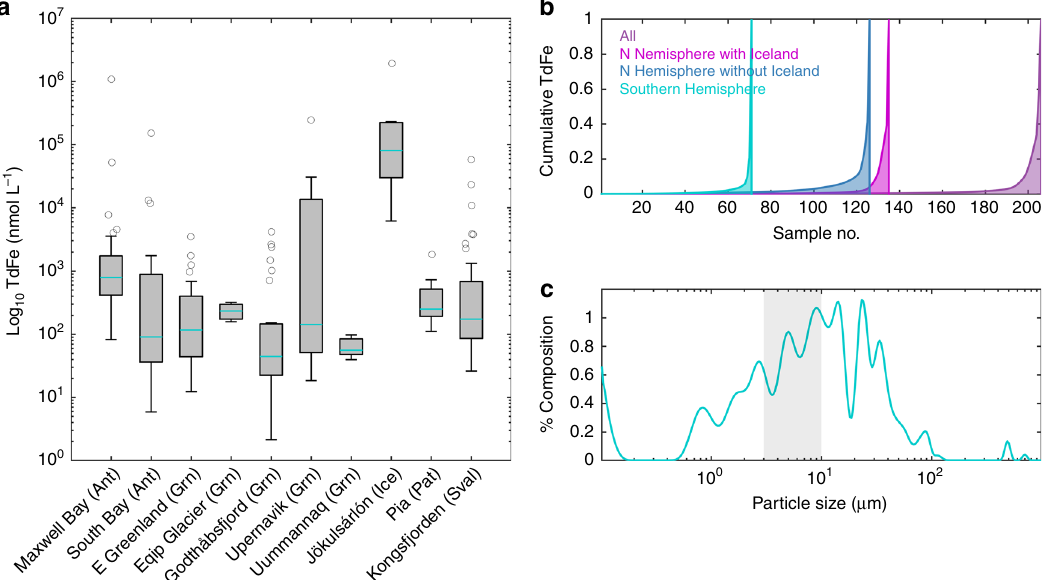
Fig. 1 Iceberg iron and particle content. a Iceberg iron (total dissolvable Fe) content per catchment. Boxes show median, 25 th and 75 th percentiles; whiskers show 10 th and 90 th percentiles; dots mark all outliers. Regions: Antarctica (Ant), Greenland (Grn), Iceland (Ice), Patagonia (Pat), Svalbard (Sval). Data only shown for catchments where n > 4. Source data are provided as a Source Data File. b Cumulative distribution plots of the Fe dataset sorted by increasing Fe content. c Lithogenic iceberg-borne particle size. Percentage composition from analysis of sediment samples retained from icebergs in Svalbard ( n = 51). Shaded area corresponds to coarse atmospheric